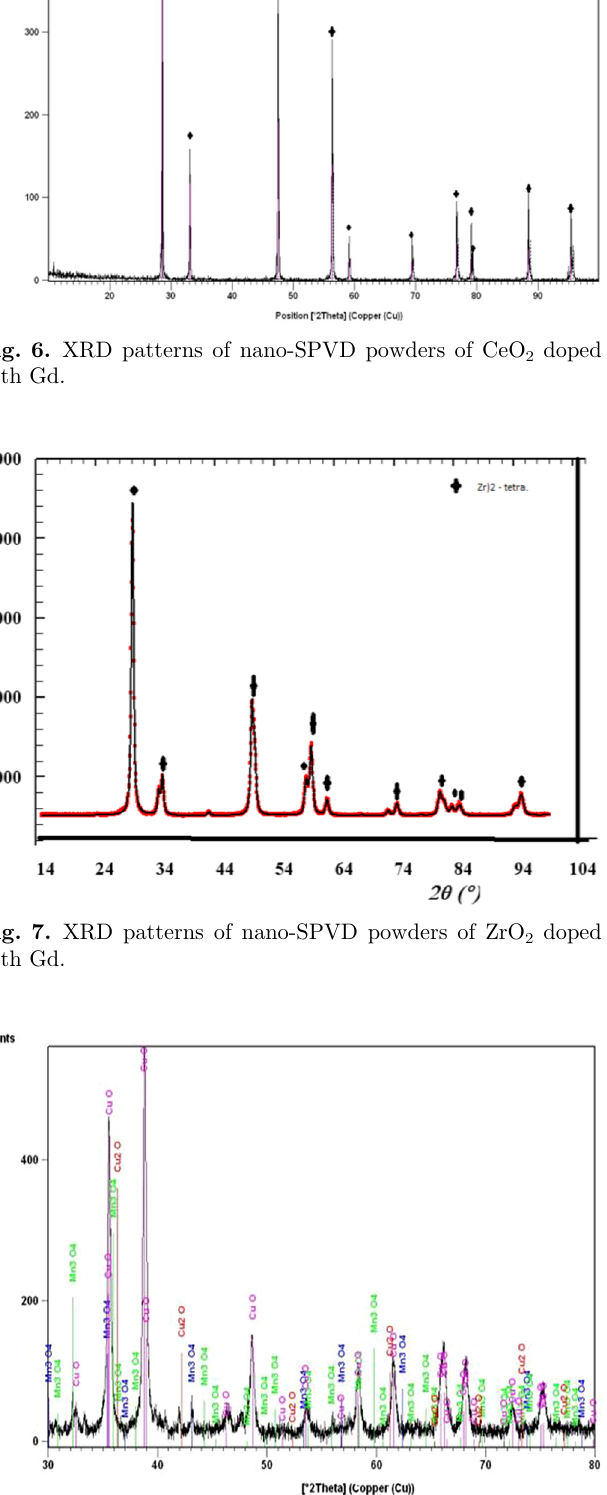
Fig. 8. XRD patterns of nano-SPVD powders of CuO doped with Mn.